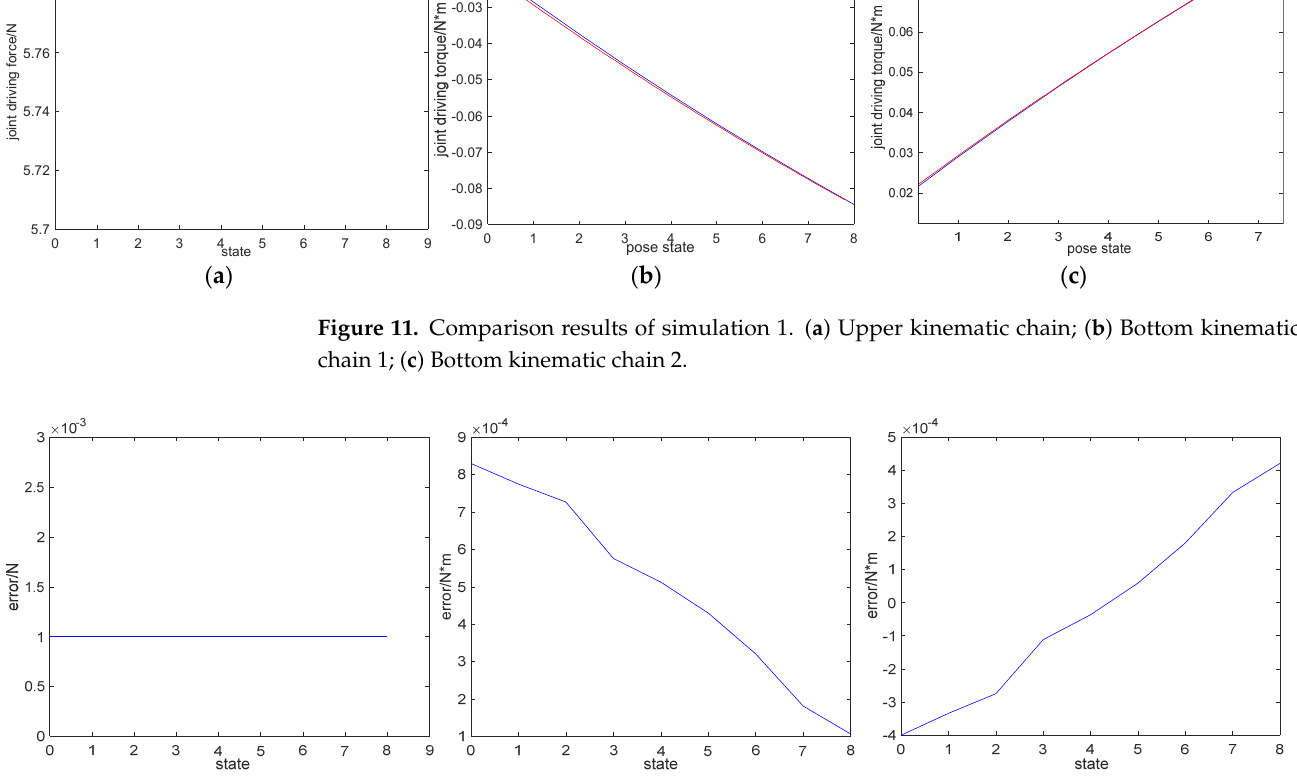
( c ) Figure 13. Comparison results of simulation 2. ( a ) Upper kinematic chain. ( b ) Bottom kinematic chain 1. ( c ) Bottom kinematic chain 2.